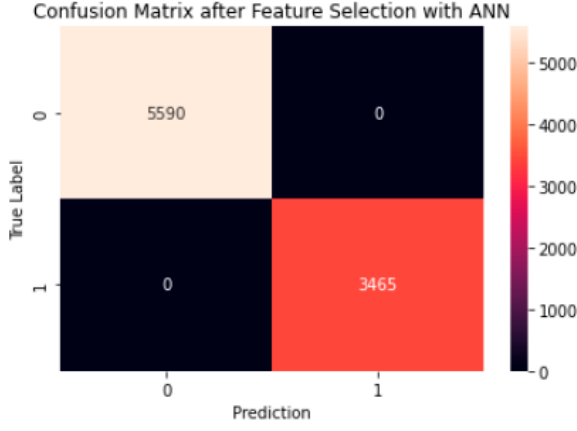
Figure 7. Confusion Matrix of ANN Detection.